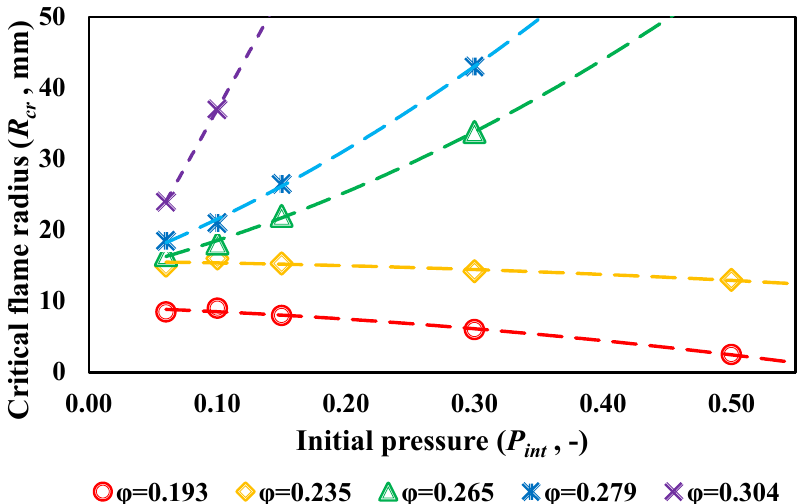
Figure 8. Critical flame radius effect on the buoyant instability for hydrogen-air premixed flames with initial pressure for different equivalence